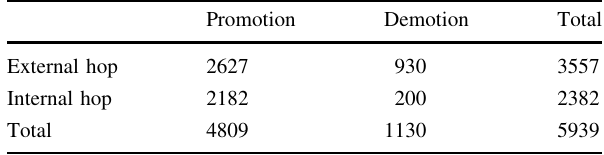
Table 4 Hop classification statistics for Singapore dataset